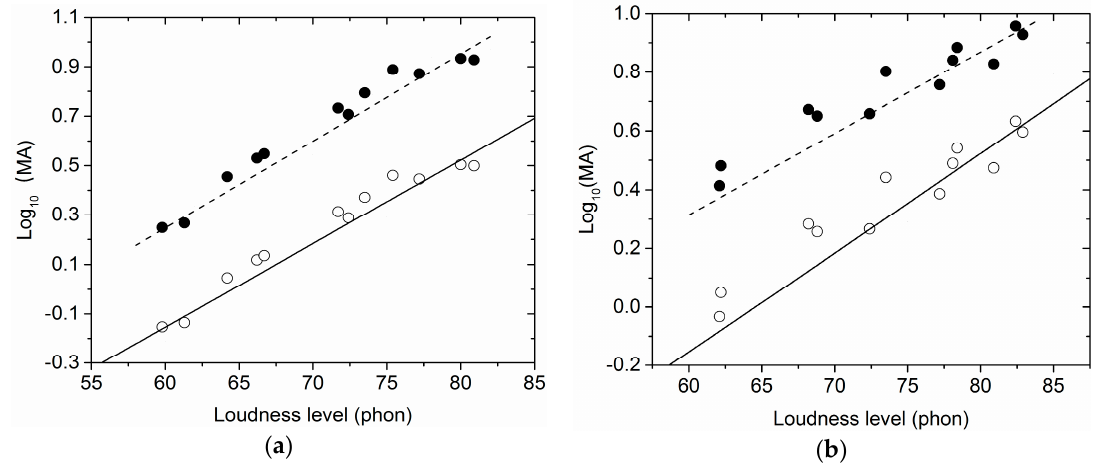
Figure 2. The relationship between L N and logarithmic MA of the 12 noise samples in sample set 1 and sample set 4 before and after calibration. ( a ) sample set 1; ( b ) sample set 4. ( ● : before calibration; ○ : after calibration; solid line: the standard curve; and dotted line: the reference curve).